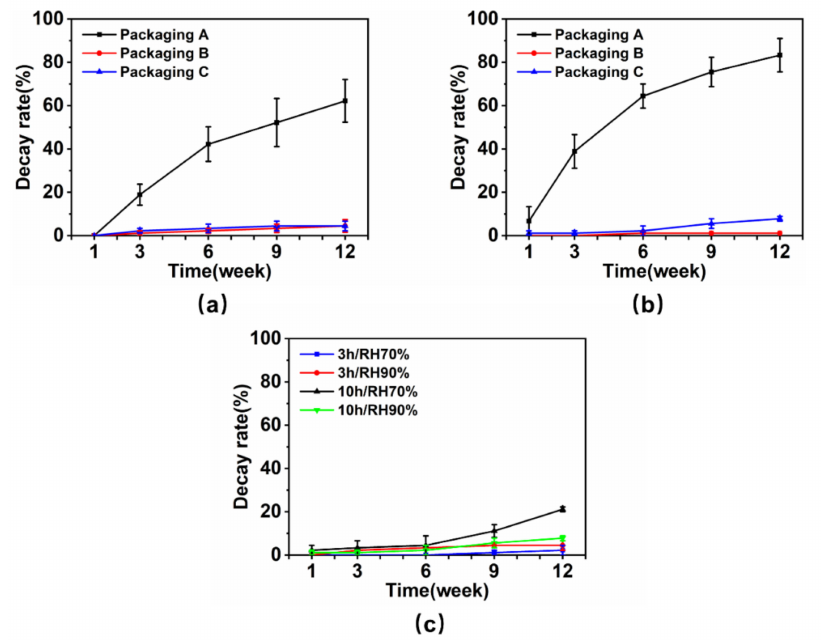
Figure 7. Decay rates during storage after simulated transportation: ( a ) Three packaging formats vibrated at 20 ◦ C and 90% RH for 3 h. ( b ) Three packaging formats vibrated at 20 ◦ C and 90% RH for 10 h. ( c ) Packaging C vibrated at 20 ◦ C and 70% RH and 90% RH for 3 and 10 h. Vertical bars represent standard